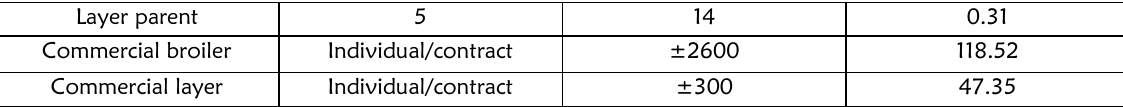
Figure 2 highlighted the distribution of commercial broiler farms around Peninsular Malaysia with Johor has the most farms and led by Perak where the case study broiler farm is located. Due to severe market competition between the chicken industries, the number of farm companies has been reduced but are getting bigger in production capacity. As seen on Table 1 and Figure 2, number of farms decrease from 2600 in 2013 to 2403 in 2016. However, the production capacity increased from 118 million in 2013 to 818 million in